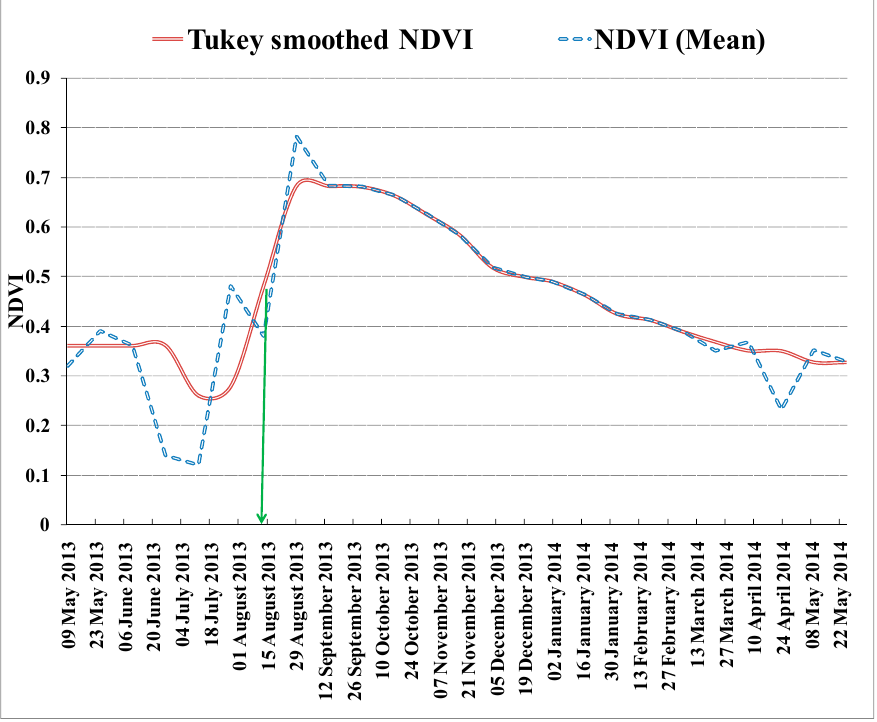
Figure 7. Raw MODIS NDVI and TS-smoothed reconstructed NDVI time series of year 2013–2014 for derivation of start of the season in Tectona grandis indicated by green arrow.